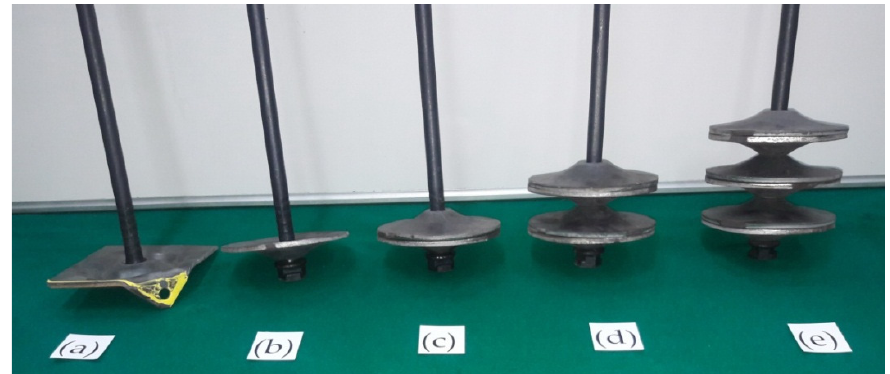
Figure 9. The bearing plates configuration used in the laboratory tests: ( a ) square shaped flat; ( b ) round profiled dome; ( c ) two round profiled domes; ( d ) four round profiled domes; ( e ) six round profiled domes.